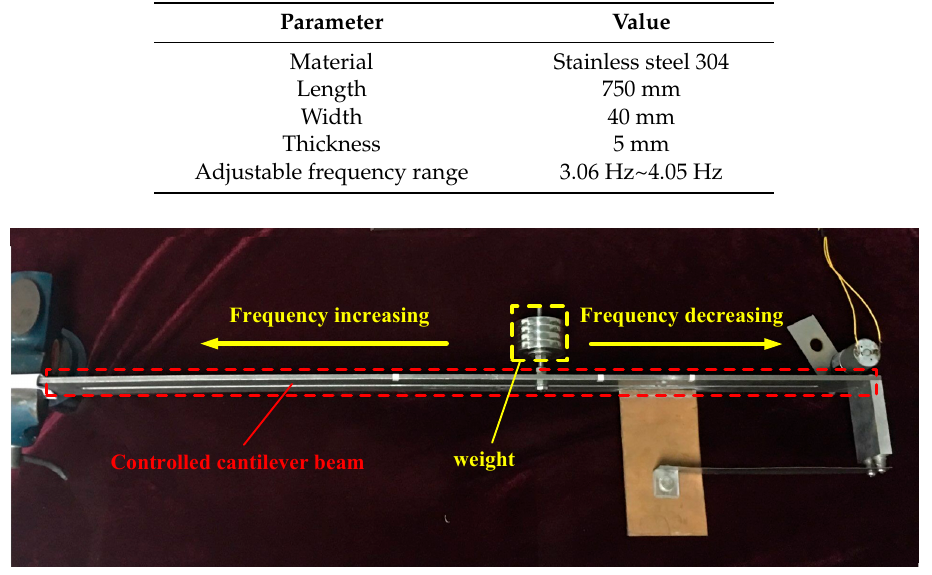
Table 2. Parameters of the small cantilever beam.